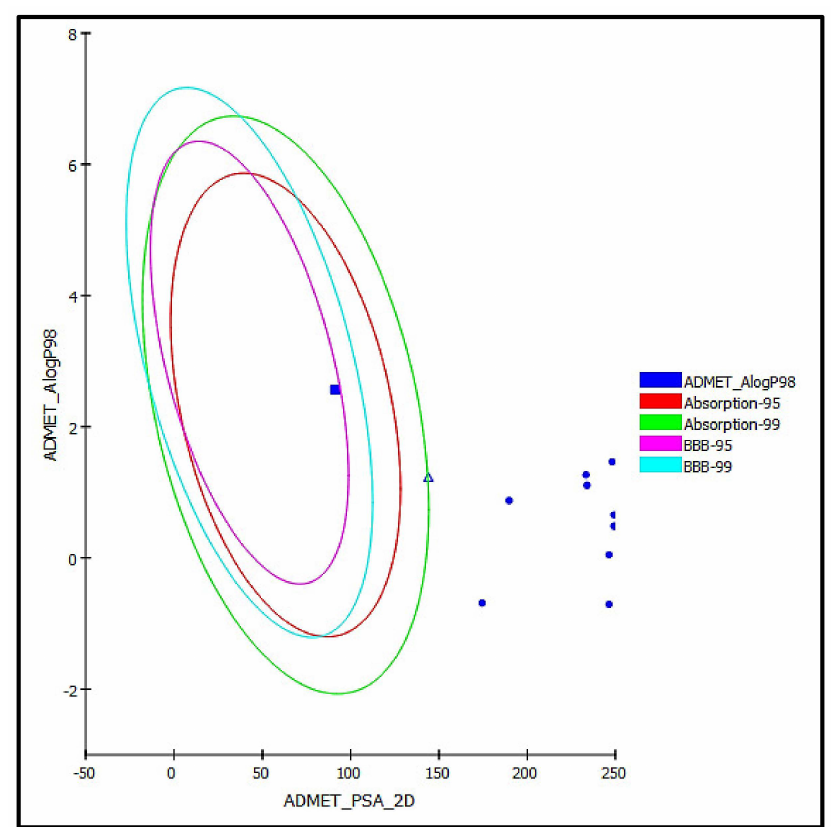
Figure 8. ADMET Plot for major compounds identified in the total methanol extract of C. speciosum showing 95% and 99% confidence limit ellipses with respect to the human intestinal absorption and the blood–brain barrier (BBB) models; rosmarinic acid (9) (triangle) and methyl ligstroside aglycone (16) (large filled